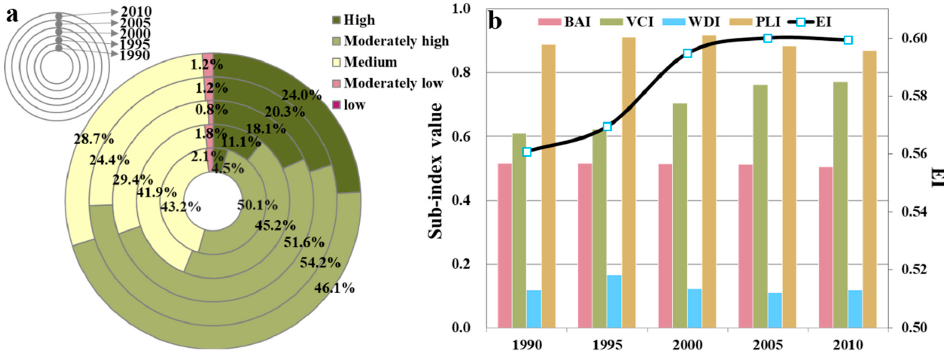
Figure 2. The EI area ratio of ecological conditions ( a ) and temporal variation of Eco_C and its sub-indexes ( b ) in the YRD during 1990–2010.